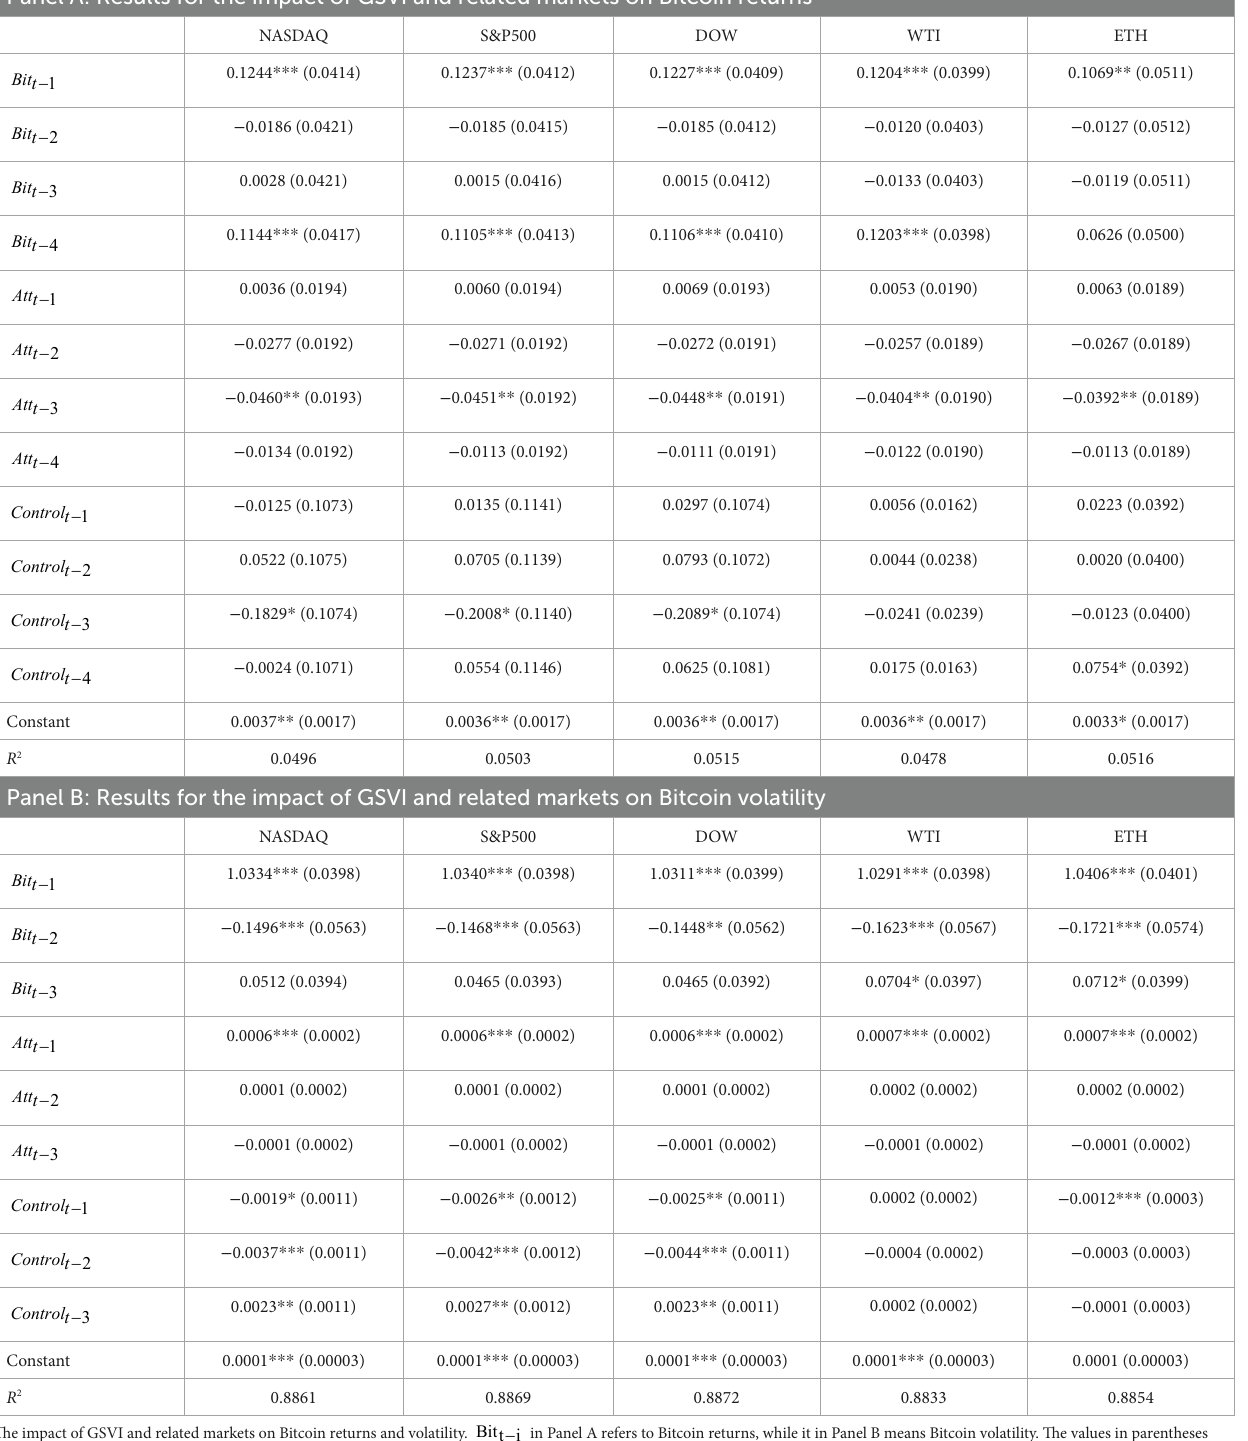
TABLE 5 Estimation results after controlling for the related markets. Panel A: Results for the impact of GSVI and related markets on Bitcoin